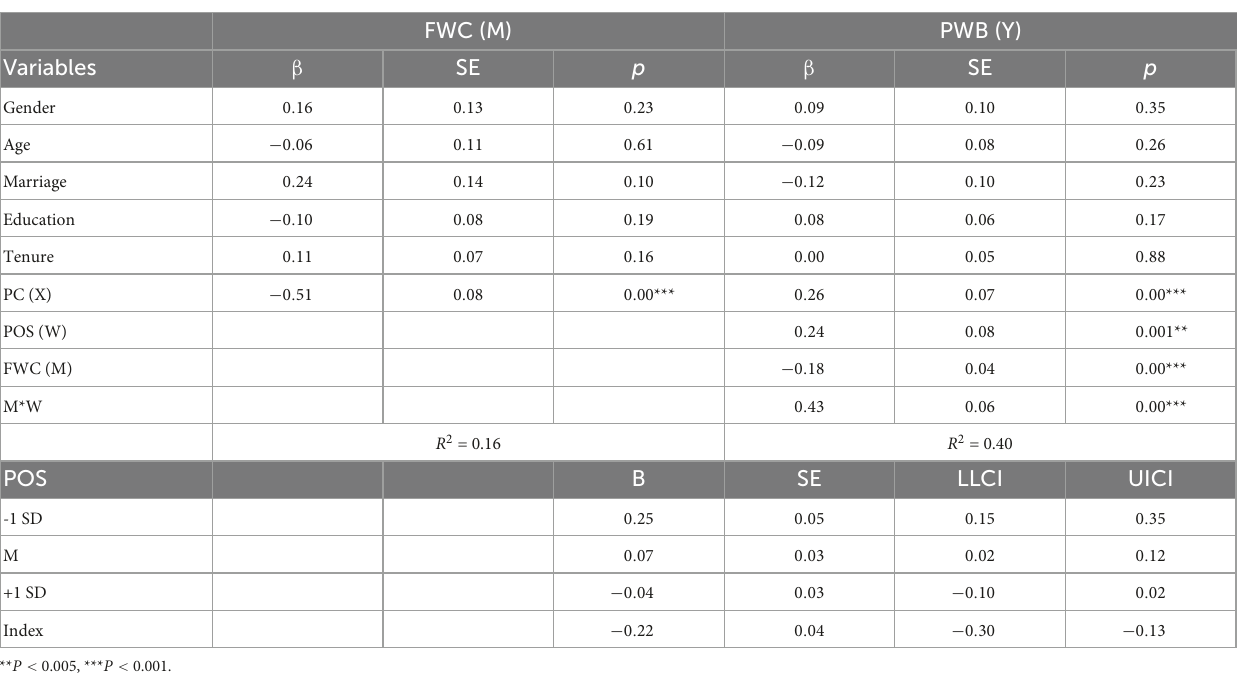
pattern. The findings in Table 6 also revealed that the conditional indirect effect was stronger in the low POS condition ( β = 0.25, CI 0.15, 0.35), and weaker in the high condition ( β = –0.04, CI –0.10, 0.02). In addition, the moderated mediation index denoted the difference between high and